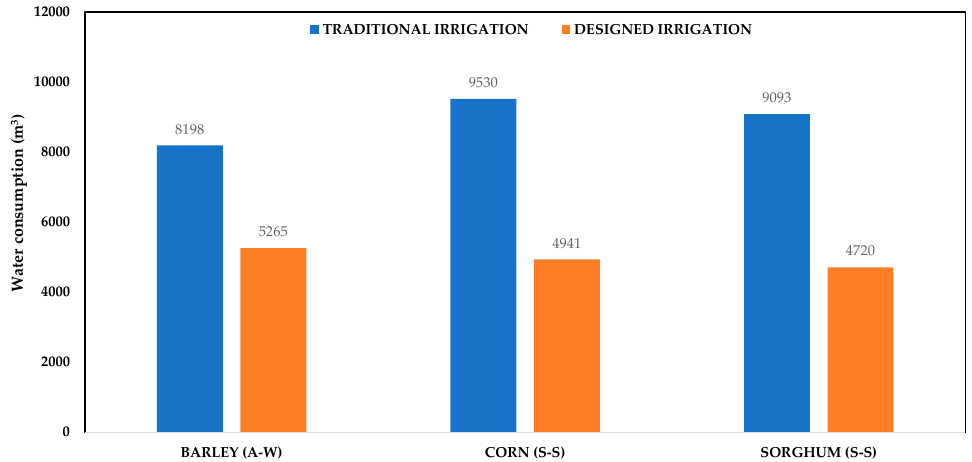
Figure 5. Water consumption in a traditional and design irrigation.